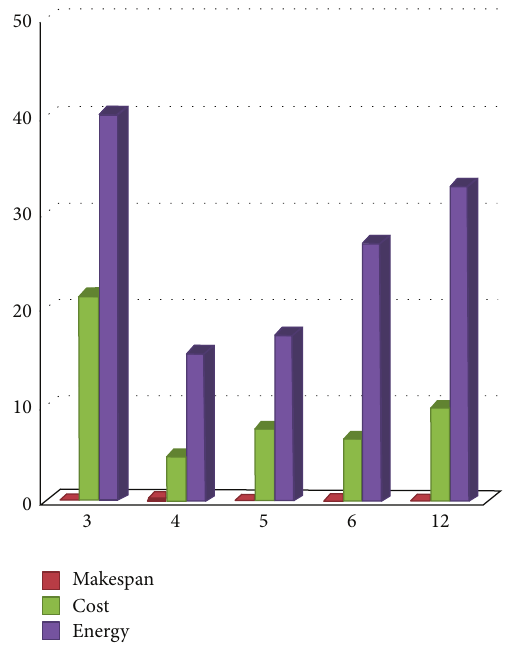
Figure 6: Gain over HEFT (%) according to the number of